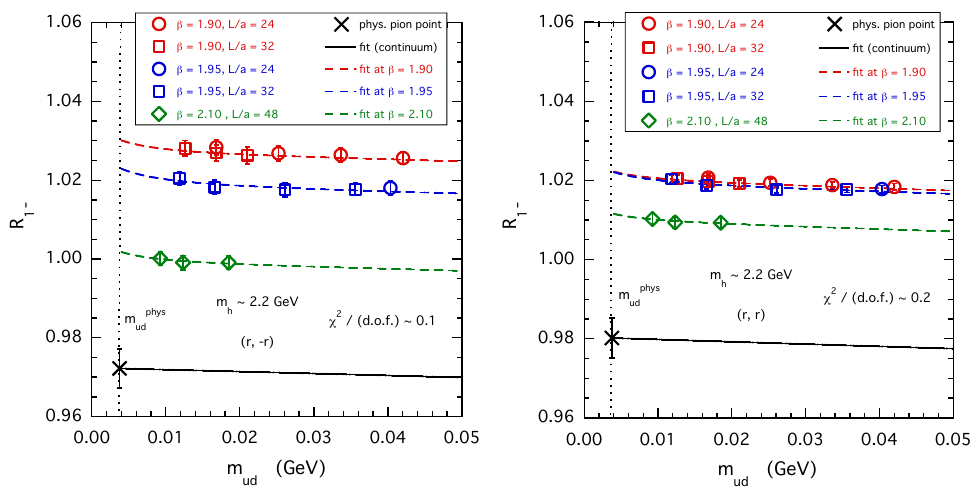
Figure 7 . The same as in figure 6, but here the solid and dashed lines represent the results of the fitting function (A.26) evaluated in the continuum and infinite volume limits and at each value of β (for the largest value of L/a